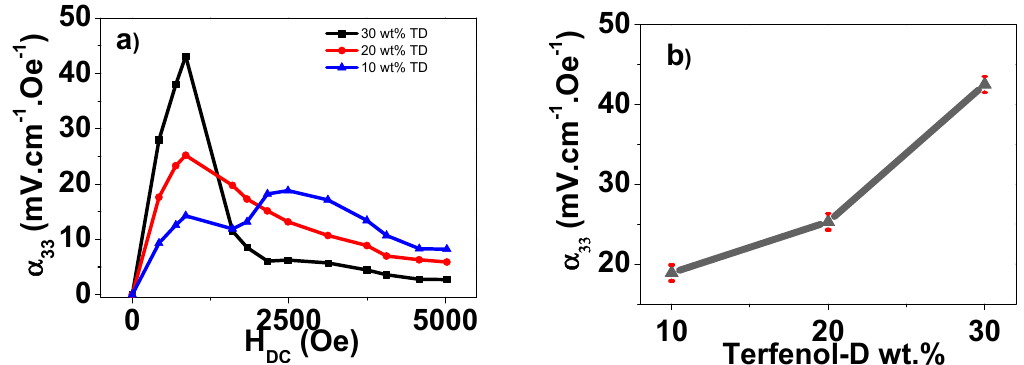
Figure 3. ( a ) ME voltage coefficient ( α 33 ) as a function of H DC for the Terfenol-D/CoFe 2 O 4 /P(VDF-TrFE) composites; ( b ) variation of the Terfenol-D/CoFe 2 O 4 /P(VDF-TrFE) highest α 33 value as a function of composite composition.